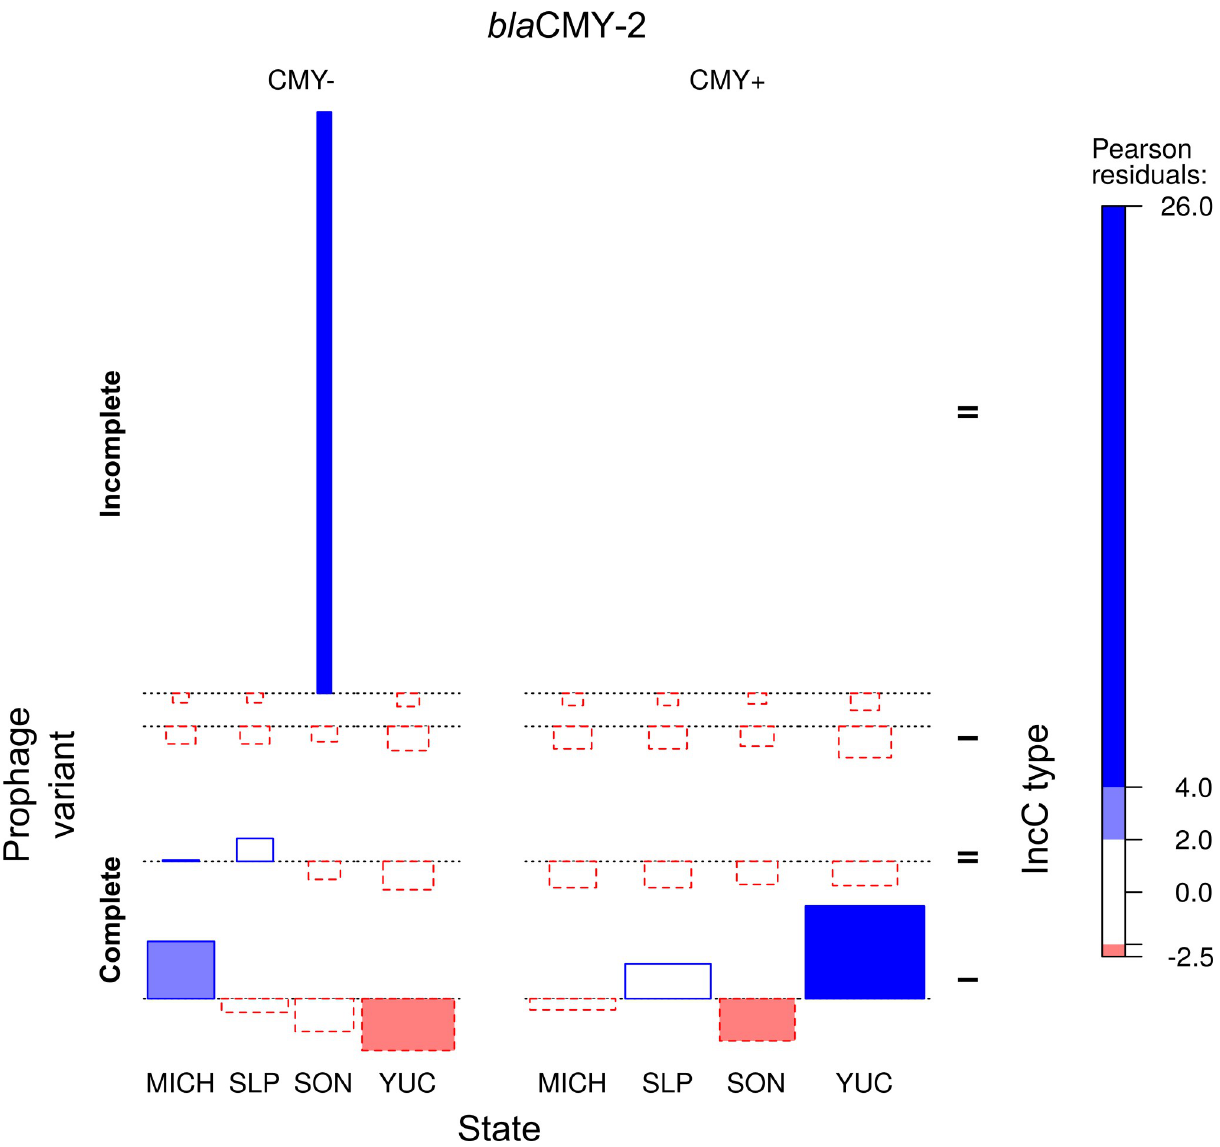
Fig 6. Graphic representation of an independence test among D6-like prophage variant, IncC plasmid type and geographic origin for 60 Typhimurium ST213 strains. An association analysis was performed on the multi-way contingency table for four categorical variables: 1) D6-like prophage variant (complete or incomplete); 2) Geographic isolation region (MICH: Michoaca´n, SLP: San Luis Potosı´, SON: Sonora or YUC: Yucata´n); 3) IncC plasmid type (I or II); and 4) IncC plasmid carrying or lacking the bla CMY-2 region (CMY+ or CMY-). The height of the bars indicates the magnitude of the Pearson residuals, their width is proportional to the sample size and the color shading denotes the sign. Negative residuals are highlighted by dotted borders.